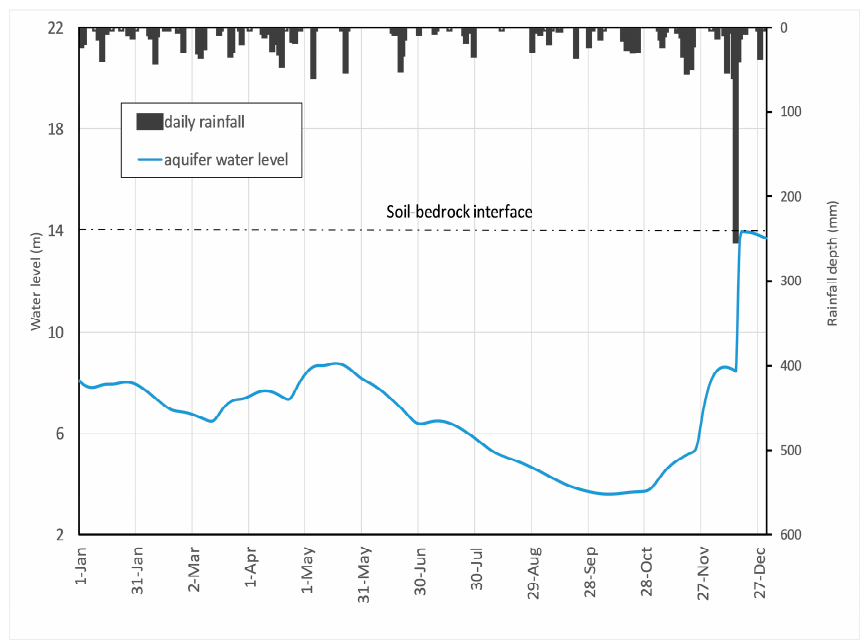
Figure 6. Daily hyetograph and simulated epikarst aquifer water level during 1999.